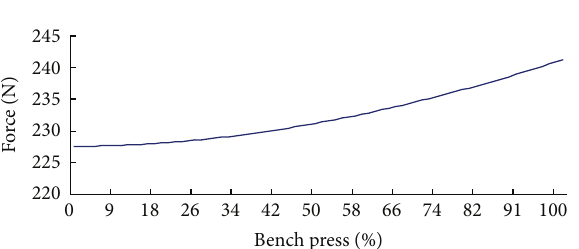
doubled shoulder widths corresponding to 40% (40 cm), 50% (50 cm), and 60% (60 cm) of the doubled